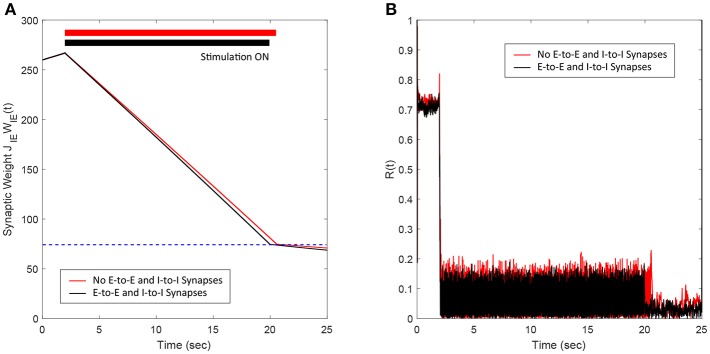
Efficacy of the FTSTS strategy in desynchronizing 2,000 neuron E-I network in the presence of E-to-E and I-to-I synaptic connectivity (black line). (A,B) Show the changes in the average E-to-I synaptic weight of the network and the network synchrony level, respectively. The red line in (A) Shows the decrease in average synaptic weight of a network with only E-to-I and I-to-E synapses. The FTSTS pulse parameters are Ustim = 100 mV, Tstim = 1 ms, and Tneutral = 10 ms.